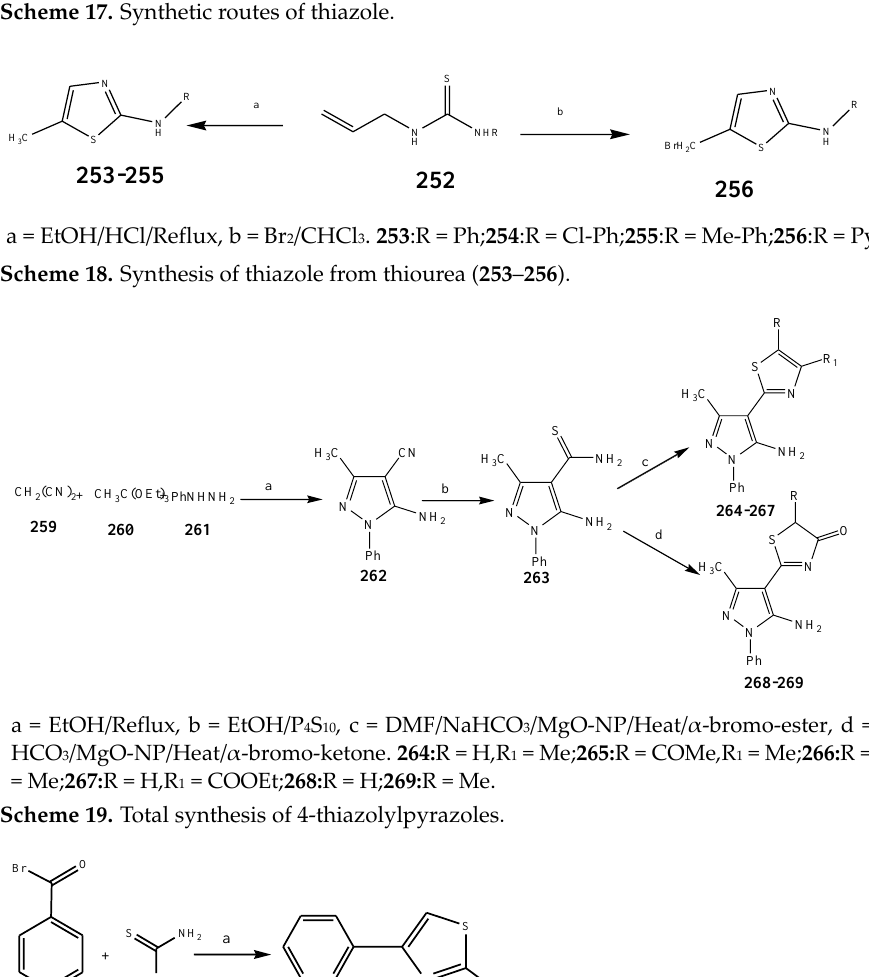
Scheme 17. Synthetic routes of thiazole.